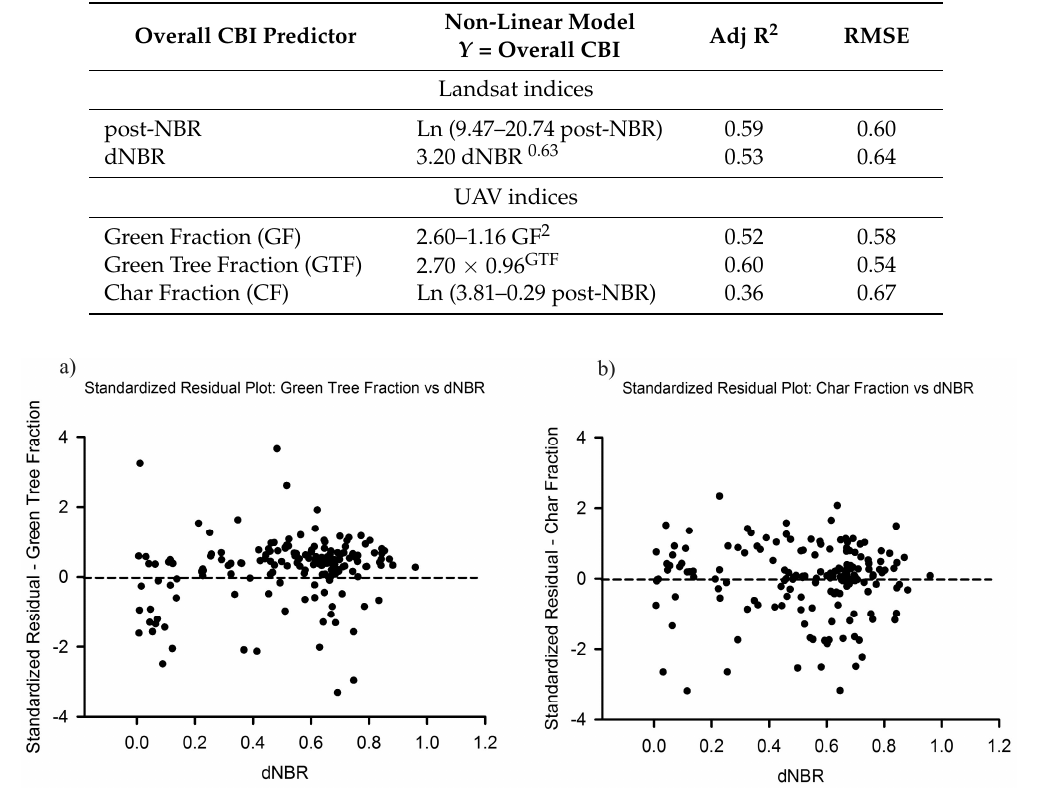
Figure 5. Standardized residual plots derived from the fitted relationships shown in Figure 4e ( a ) and Figure 4f ( b ) depicting no bias and a homogeneous pattern across the range of